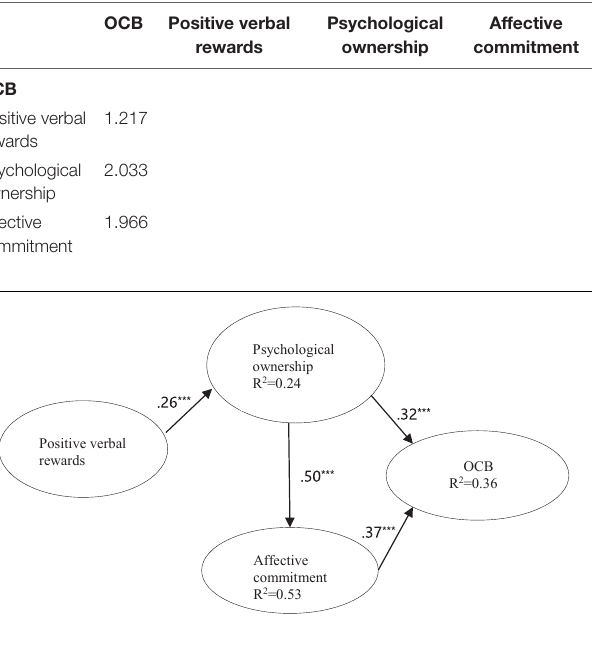
FIGURE 1 | Structural model testing results. *** p <